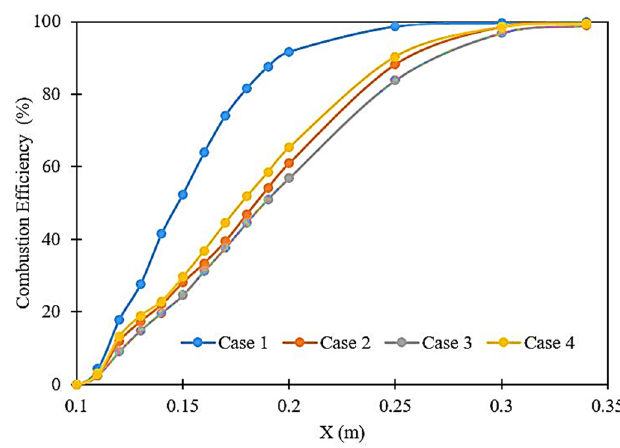
Figure 12. Combustion efficiency of the various cases along the axial direction of the combustor.